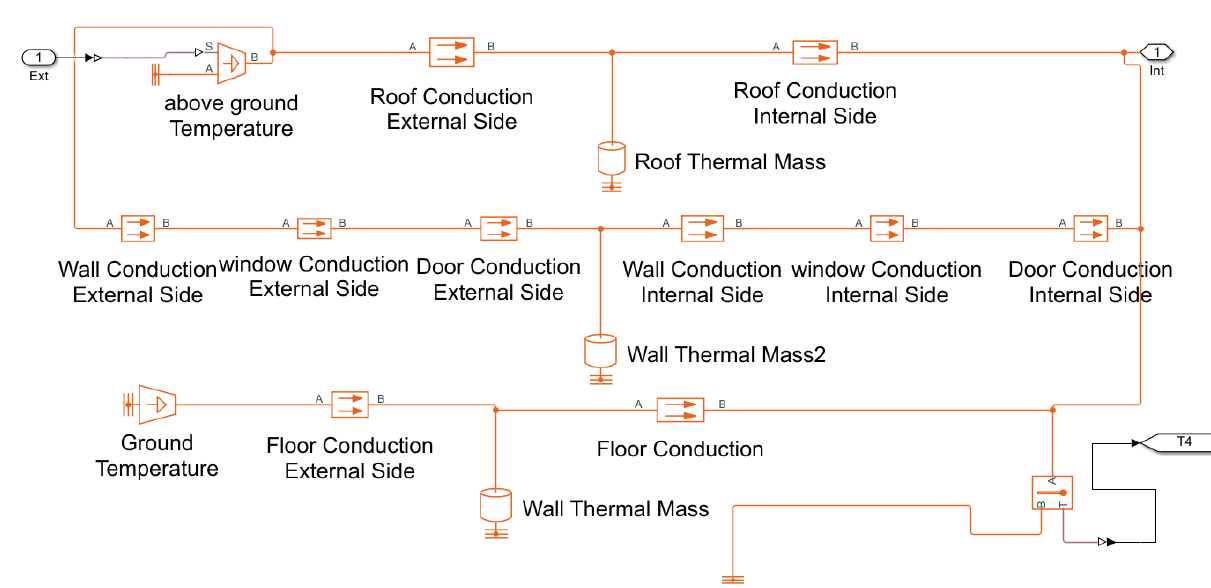
Figure 4. The thermal resistance schematic of the test ventilation system.